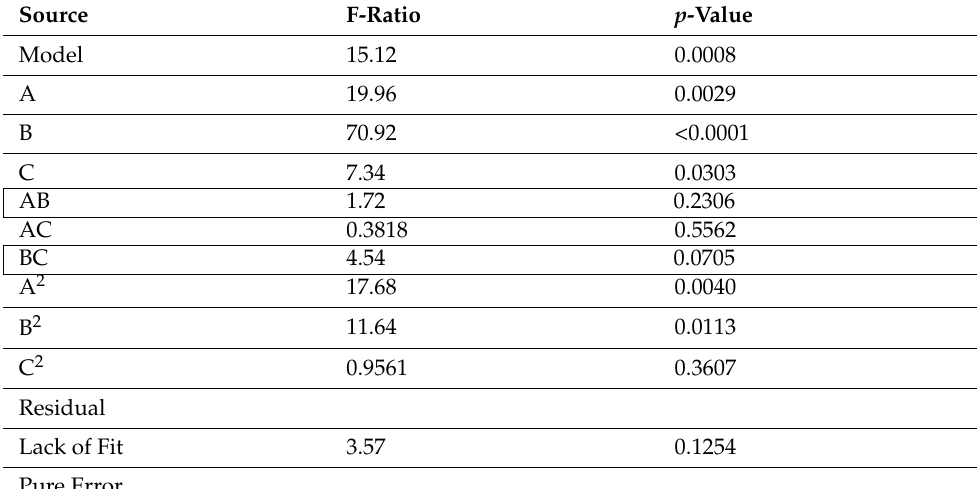
Table 5. Analysis of variance data for